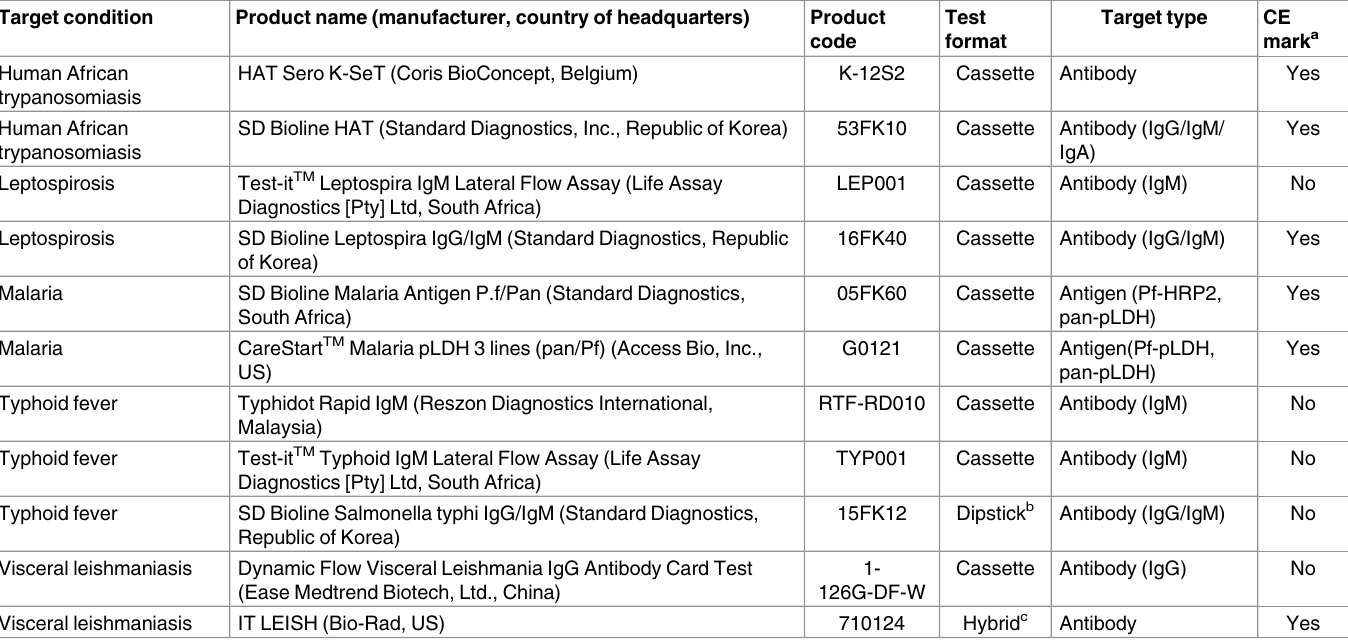
Table 1. Characteristics of 11 rapid diagnostic tests used in the NIDIAG persistent fever study. Target